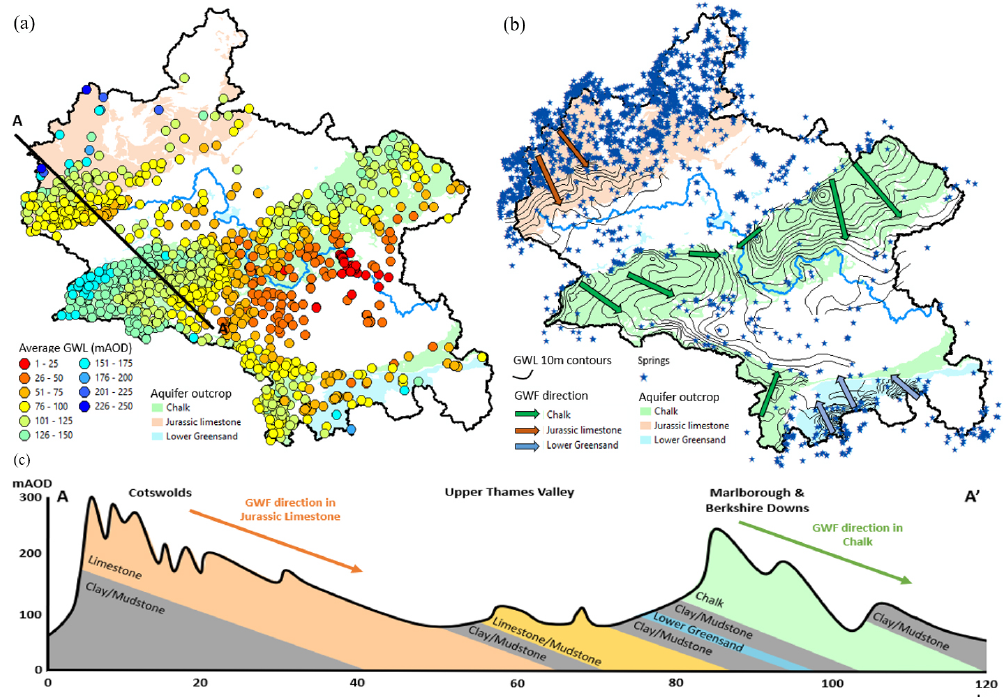
Figure 3. Hydrogeological features and characteristics of the Thames catchment showing (a) average groundwater levels and the location of the geological cross section in (c) ; (b) the location of springs (digitised from Ordnance Survey mapping), general “median” aquifer ground- water level contours (after Atkins, 2003, 2007; Entec UK Ltd., 2008; Environment Agency, 2010 and ESI Ltd., 2013), and flow direction arrows in relation to aquifer outcrop areas; and (c) a geological cross section showing the three main aquifers, simplified lithology, and general groundwater flow direction. Contains British Geological Survey data © UKRI 2022 and Ordnance Survey data © Crown copyright and database right